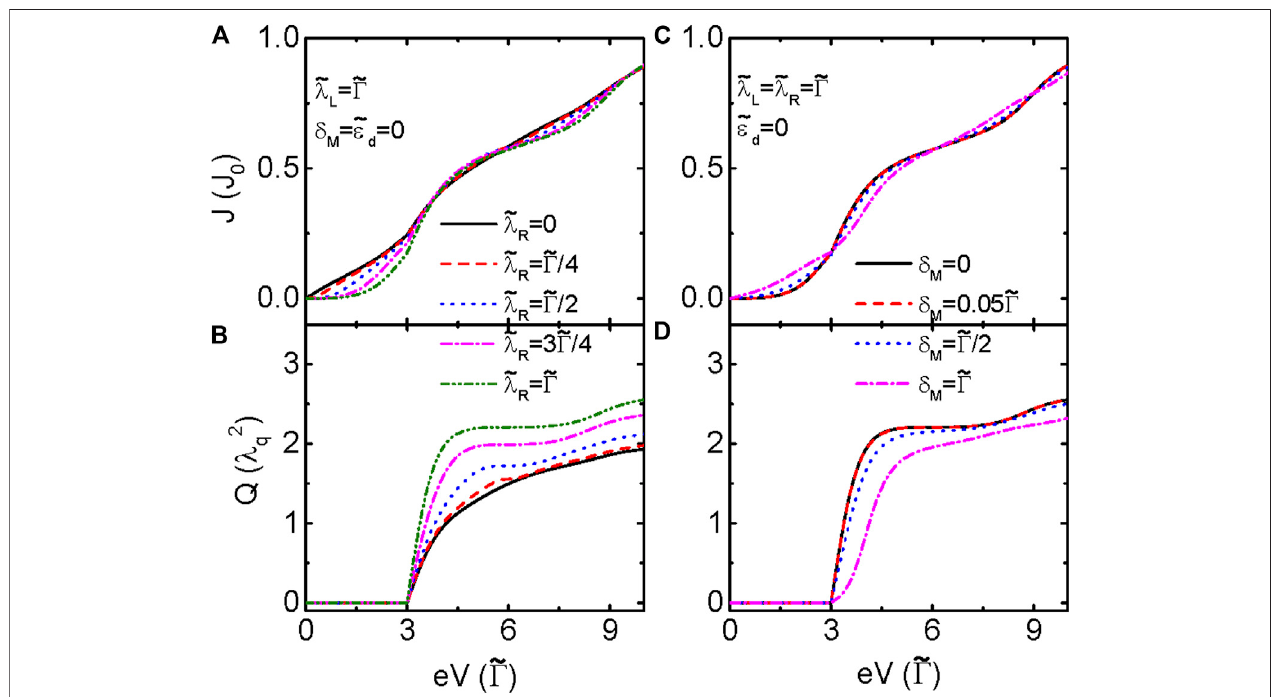
FIGURE 4 | Electrical current and heat generation (A, B) as functions of the bias voltage and (C, D) vs the dot level at different values of ~ λ R . Other parameters are given in the fi gure and the same as in Figure 2 .